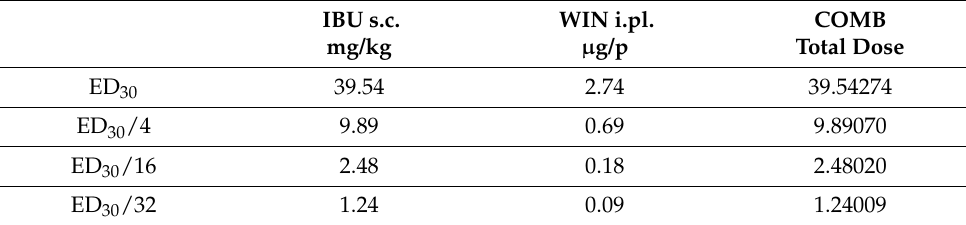
Table 2. The doses used in the study to analyze the synergism between IBU + WIN, each administered by the corresponding route